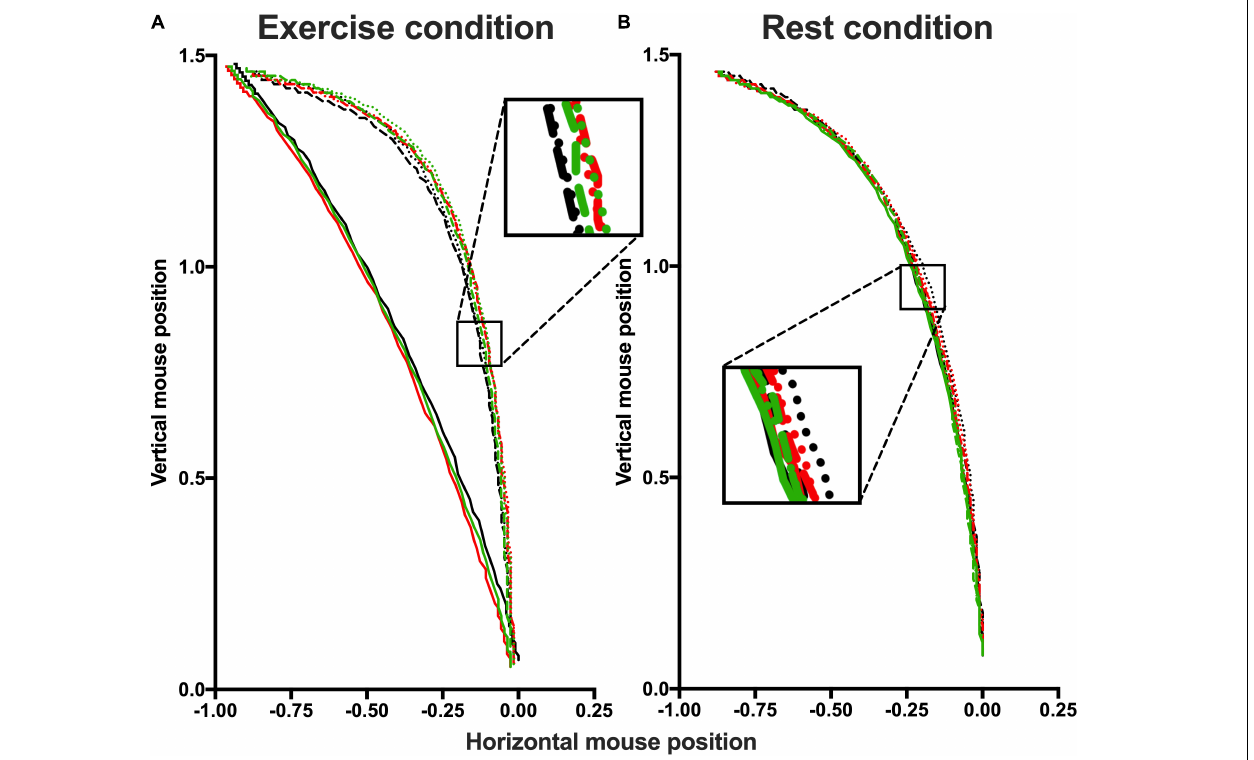
FIGURE 4 | Spatial trajectories of the correct responses of exercise (A) and rest (B) conditions. In both conditions, trajectories are presented separately for each Affective prime and divided by Prime Facial Expressions: Negative Fearful (solid black line), Negative Happy (dashed black line), Negative Neutral (dotted black line); Neutral Fearful (solid red line), Neutral Happy (dashed red line), Neutral Neutral (dotted black line); Positive Fearful (solid green line), Positive Happy (dashed green line), Positive Neutral (dotted green line). The box highlight the difference between the curves. Participants in exercise conditions show a straighter trajectory for fearful faces but not for neutral and happy